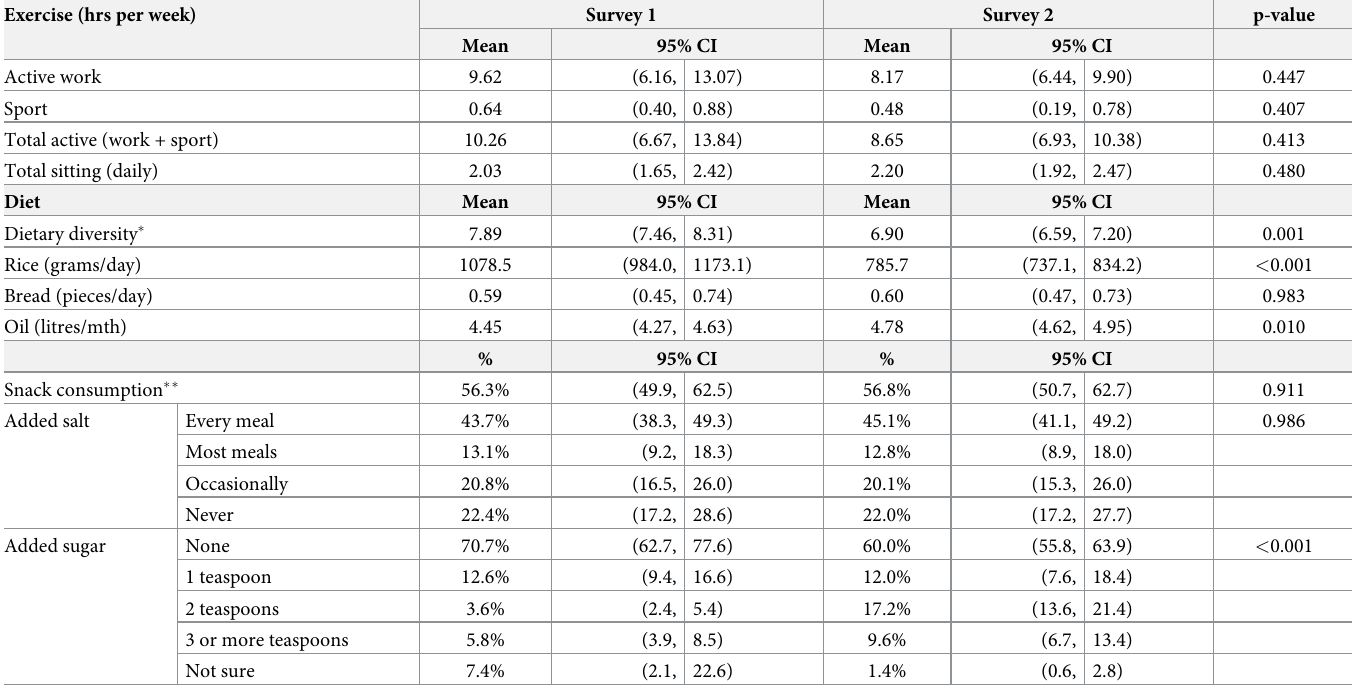
Table 5. Active work, exercise and dietary consumption in survey 1 and 2. Exercise (hrs per